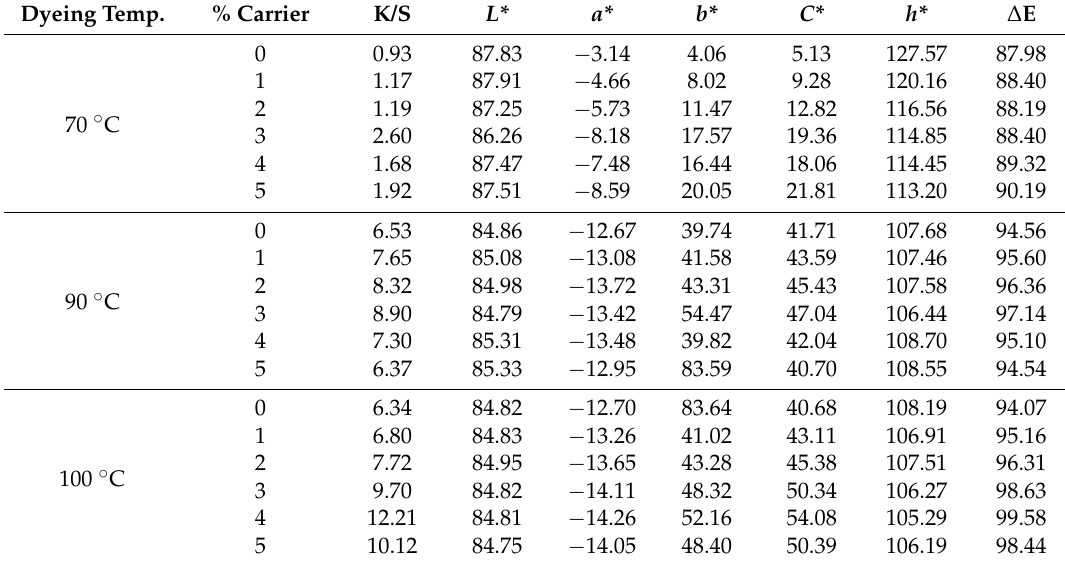
Table 1. Optical measurements of disperse dye 3a on the polyester fabrics. Dyeing Temp.